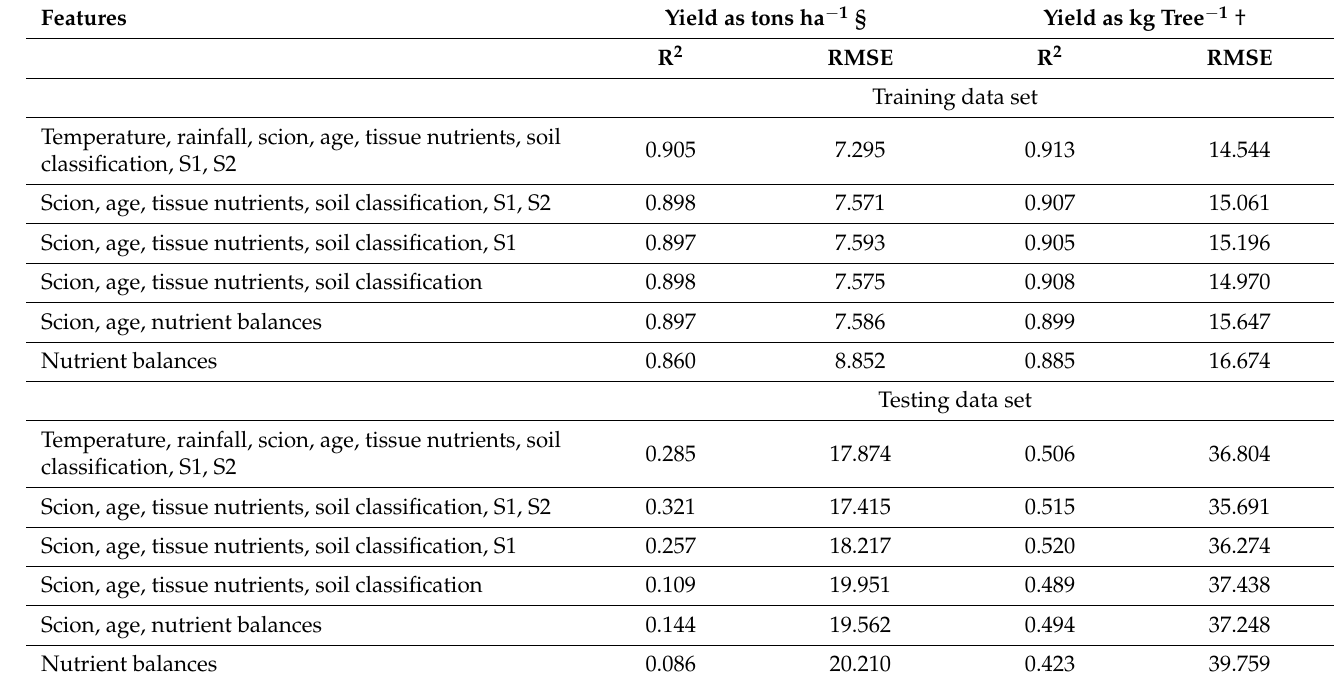
Table 4. Performance of the random forest regression model after partitioning the data set into training (70%) and testing (30%).